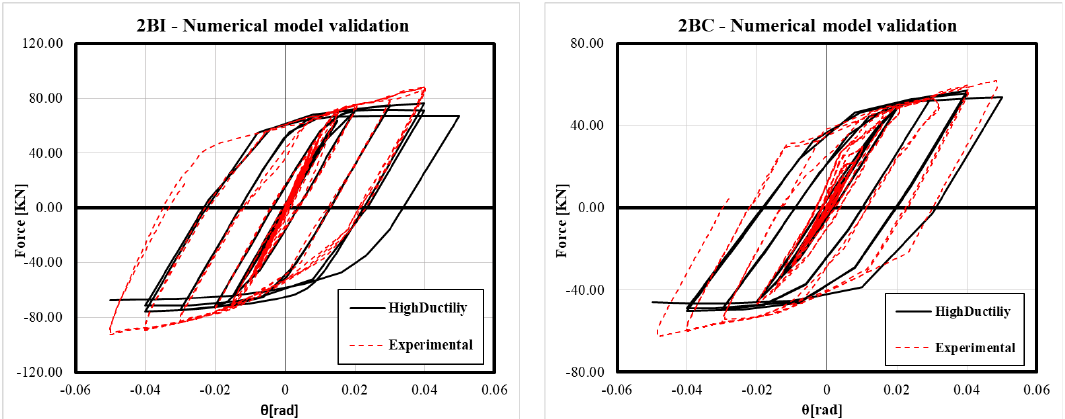
Figure 9. Comparison of the hysteresis curves of the FEM and experimental results